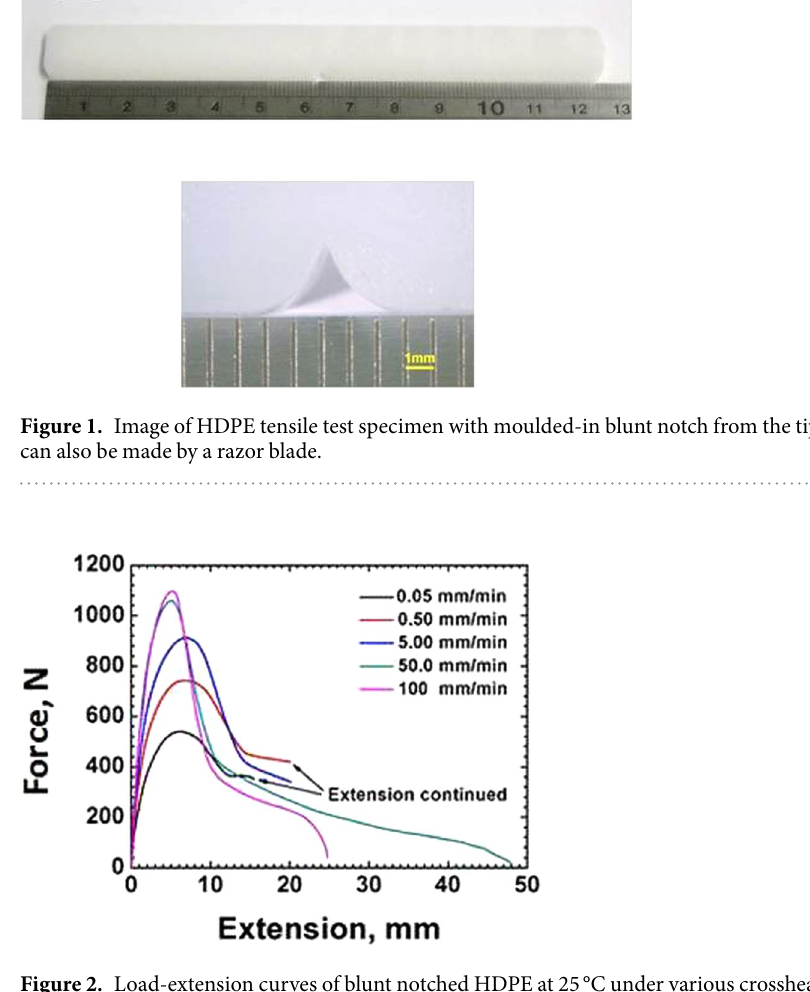
Figure 2. Load-extension curves of blunt notched HDPE at 25 °C under various crosshead speeds.